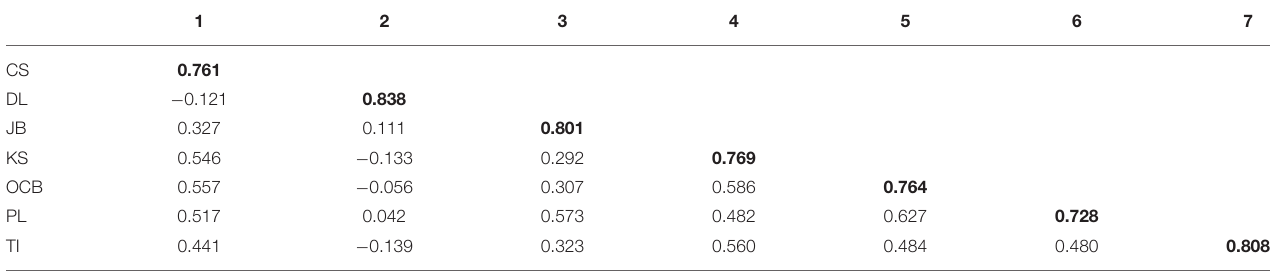
TABLE 2 | Discriminatory validity.